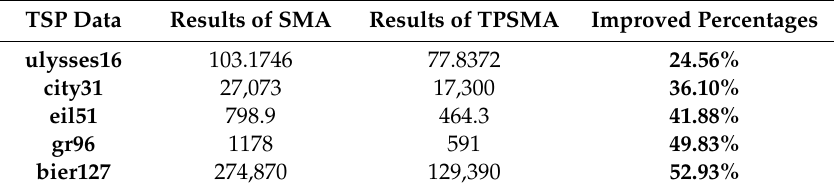
Table 4. Experimental data’s results of ulysses16, city31, eil51, gr96 and